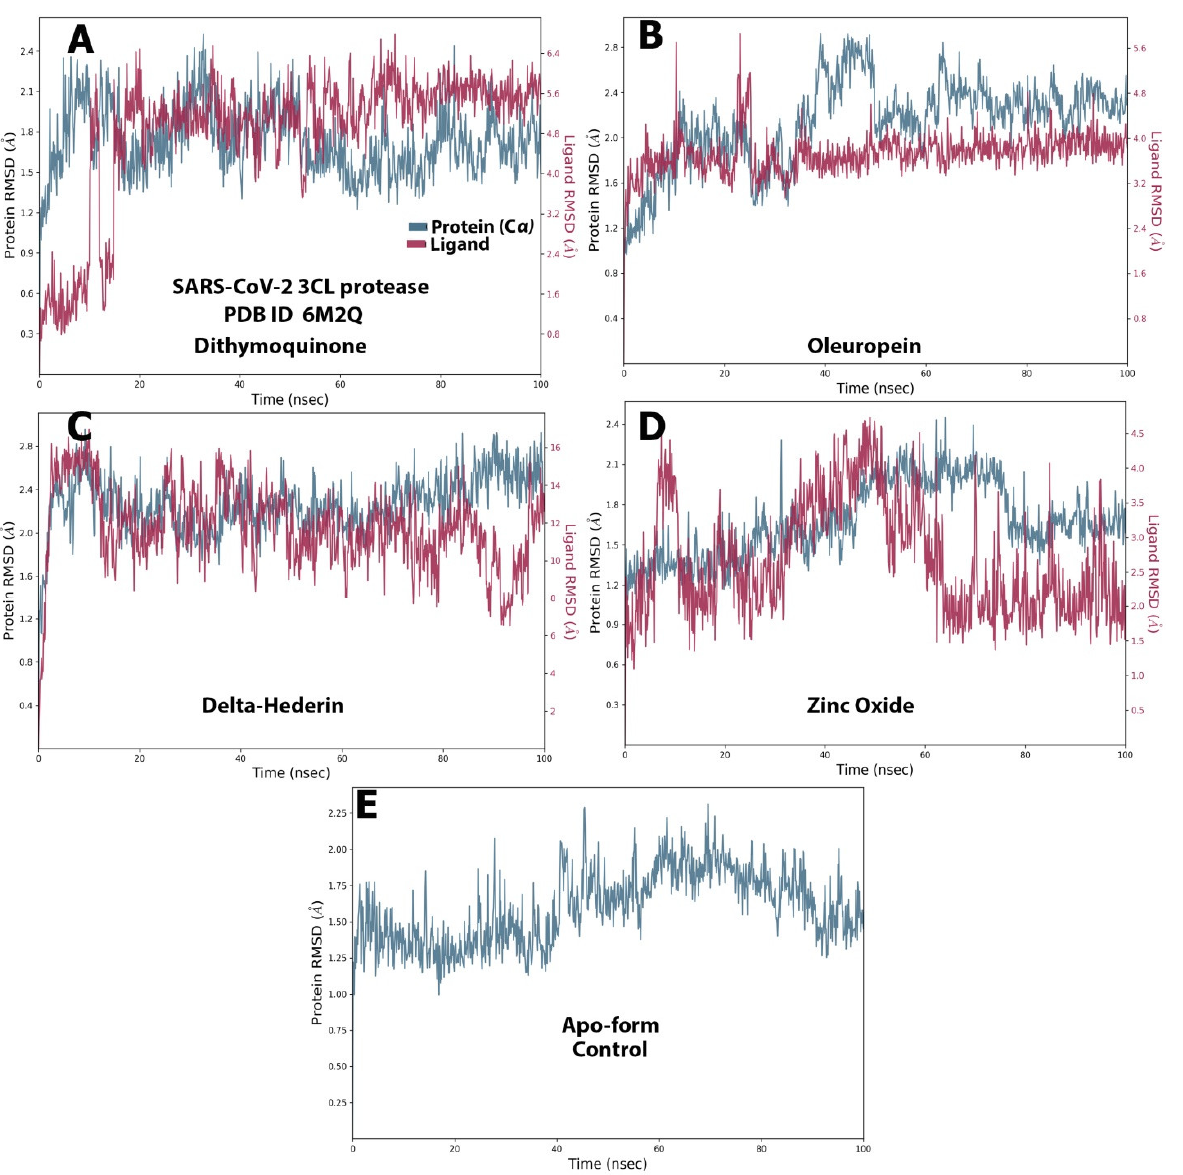
Figure 8. The protein–ligand RMSD of the optimized compounds during the 100 ns. ( A ) dithymo- quinone, ( B ) oleuropein, ( C ) delta-hederin, ( D ) zinc oxide, ( E ) apo-form as a control. The RMSF graph for the protein and ligand complexes and the apo-form is